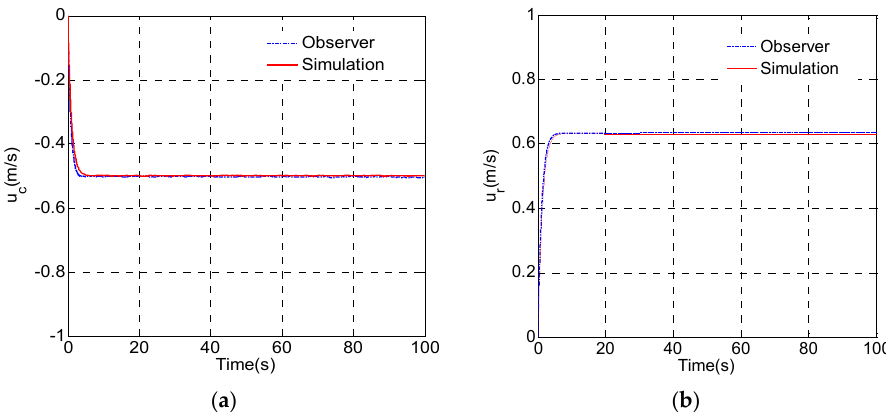
Figure 18. Observed result of velocity: ( a ) current velocity in the X direction; ( b ) relative velocity of ROV in the x direction.